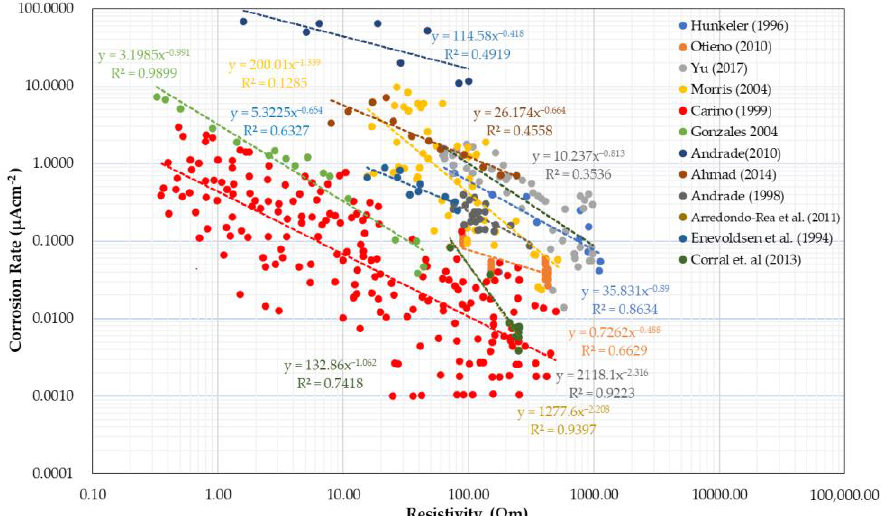
Figure 4. Summary of references showing the relationship between electrical resistivity and corrosion rate.